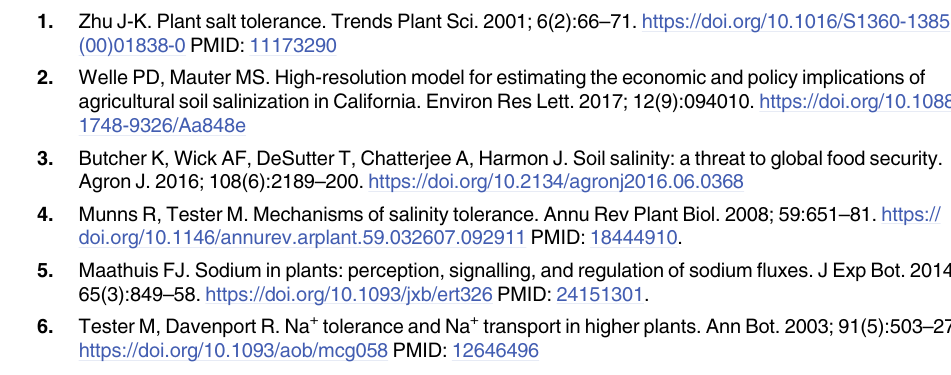
S1 Fig. PpHKT1 expression in ‘Nemaguard’ roots after 24 h of salt stress. (TIF) S1 Table. Subcellular localization prediction for the PpHKT1 protein using AtSubP web server (http://bioinfo3.noble.org/AtSubP/?dowhat=AtSubP).